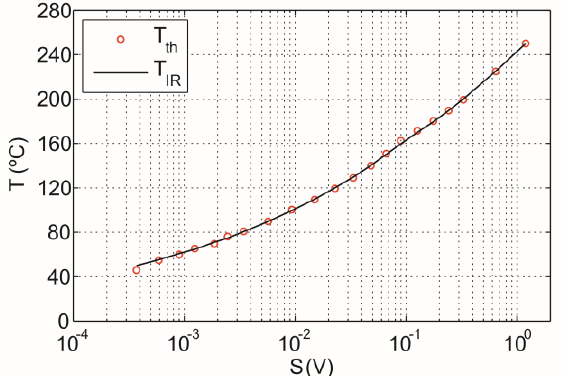
Figure 12. Calibration curve obtained from theoretical